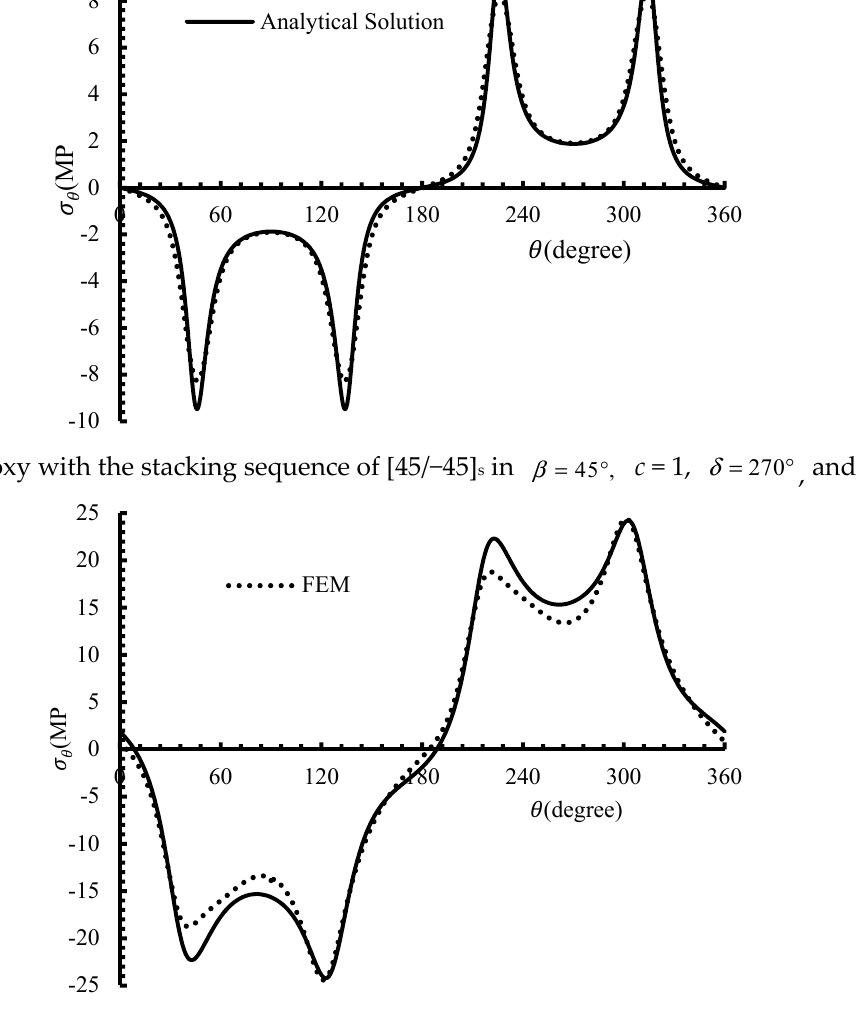
Figure 4. FEM and analytic solution comparison for different composite materials in various stacking sequence.